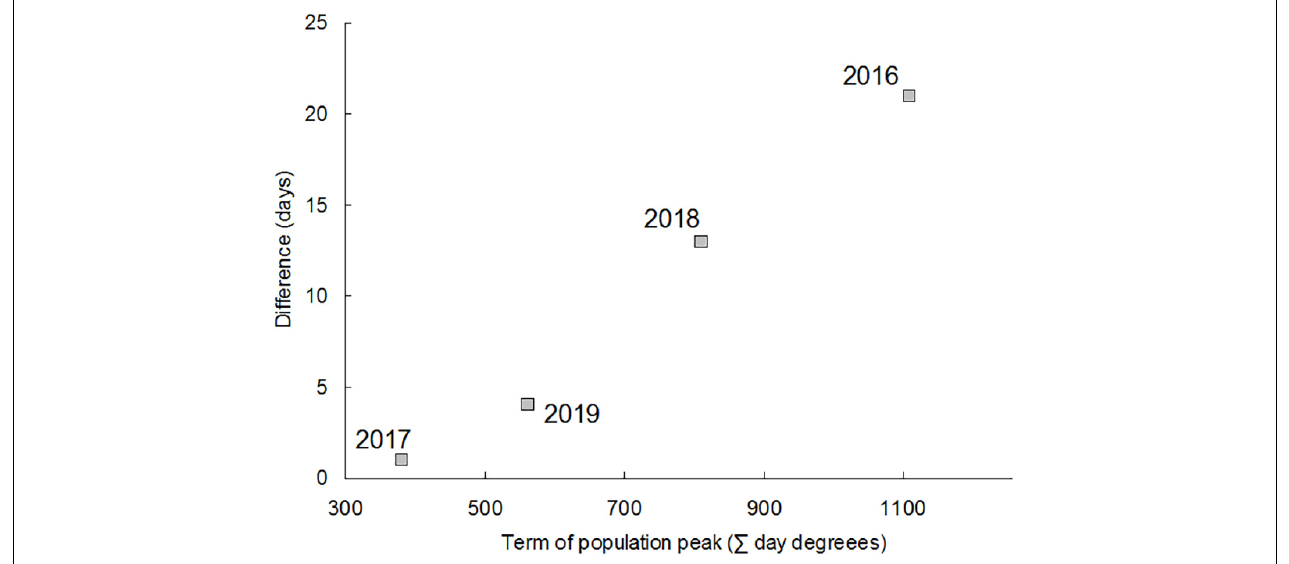
FIGURE 2 | Difference (days) between the term of the population peak in the city center and the term of the population peak in the outskirts of Prague plotted against the thermal time (day degrees) when the maximum abundances were observed (average of the thermal time value in the city center and the outskirts).